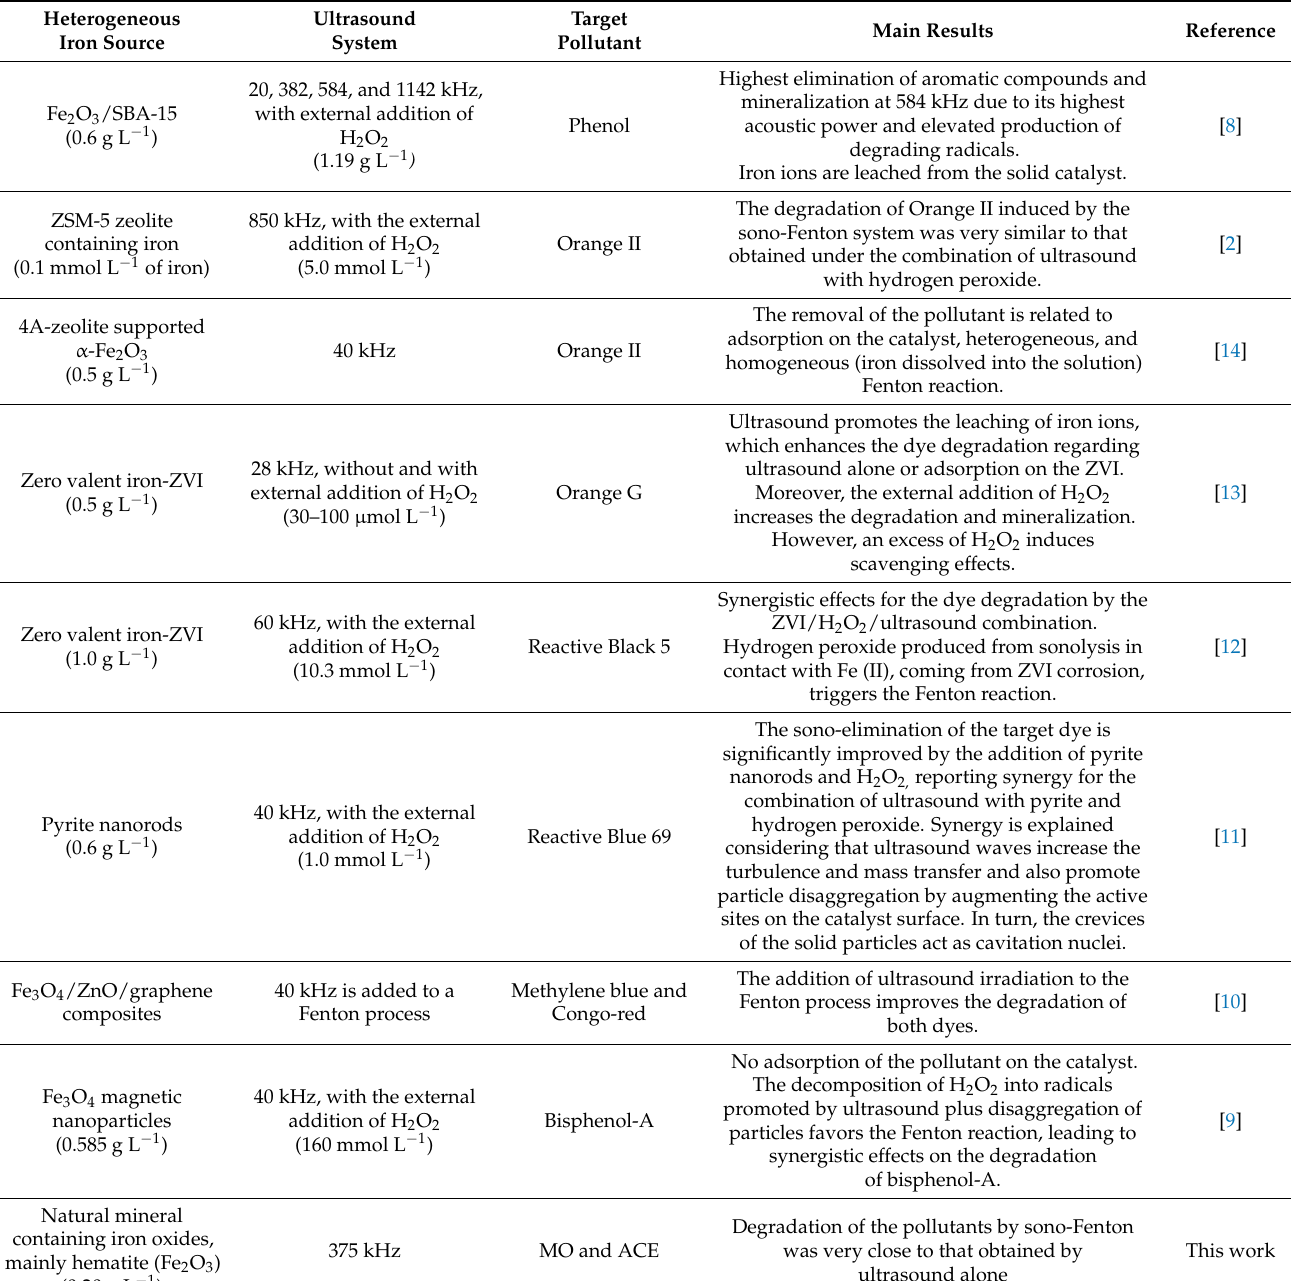
Table 1. Comparison of the tested heterogeneous sono-Fenton system with other cases reported in the